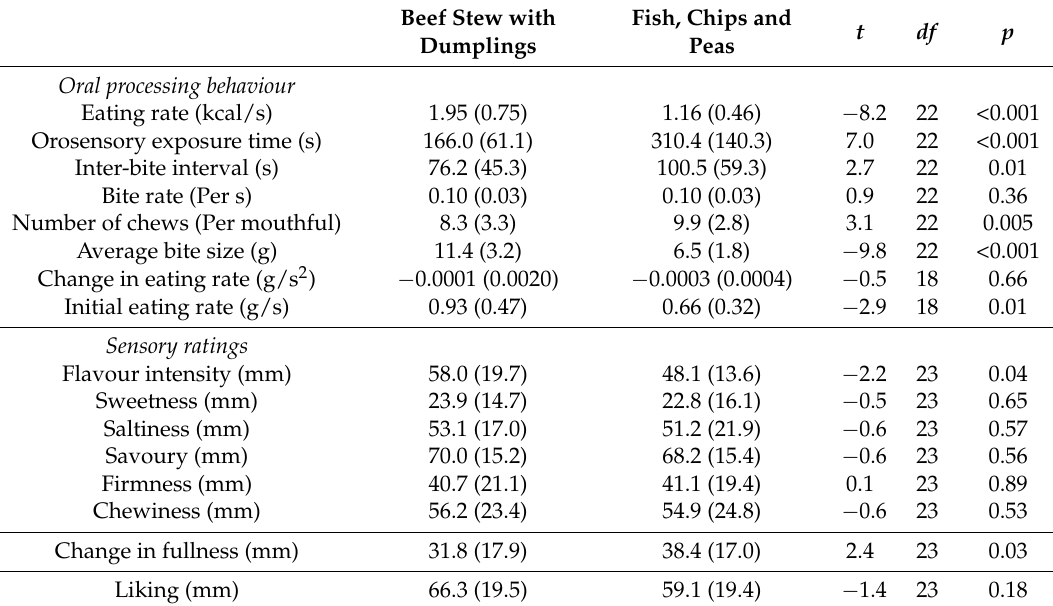
Table 6. Mean ( ˘ S.D.) scores for oral processing characteristics, sensory ratings, change in fullness, and liking across the fixed portion meals.